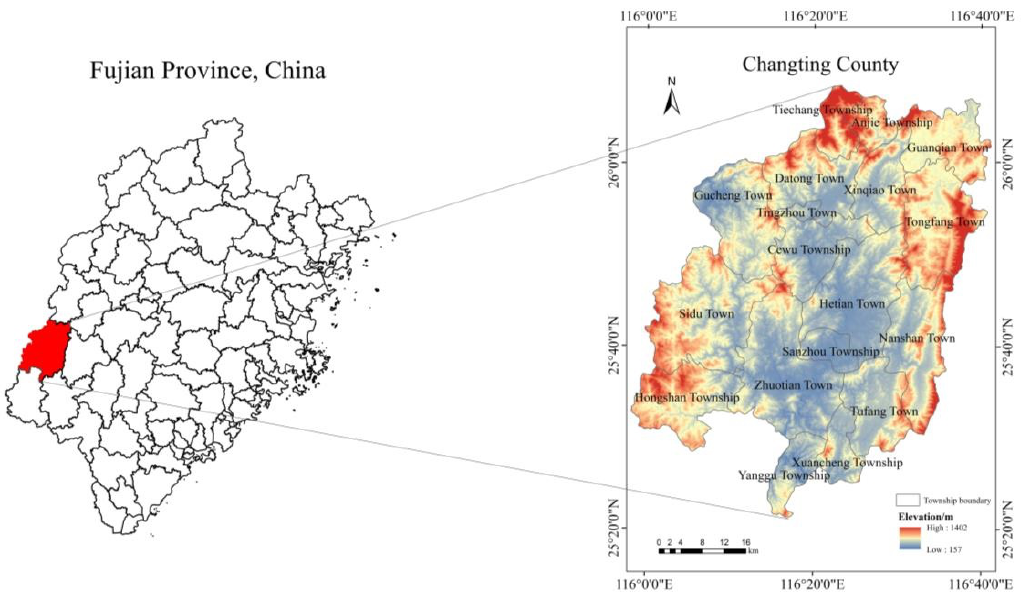
Figure 1. Location diagram of the study area.